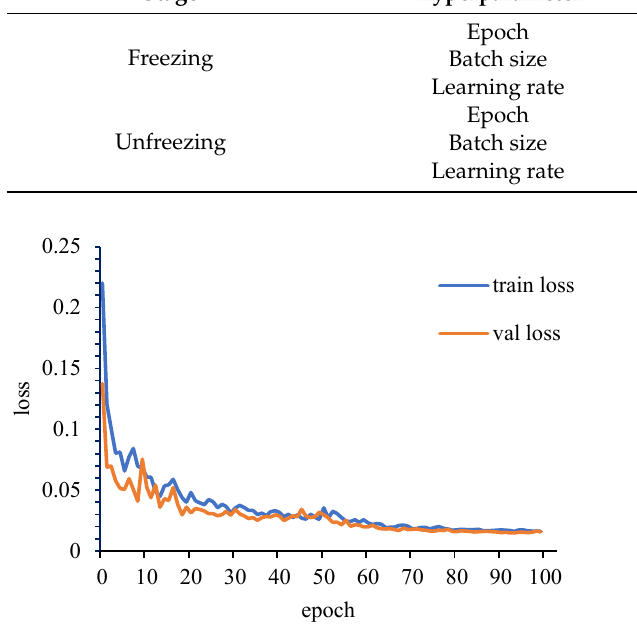
Table 2. DeepLabV3+ network training phase hyperparameter setting.